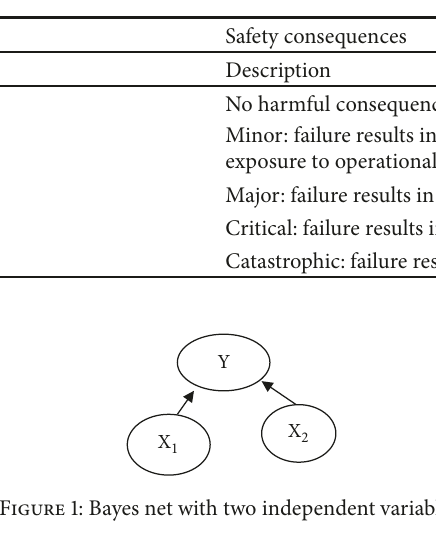
Table 1: Consequences grading scale.